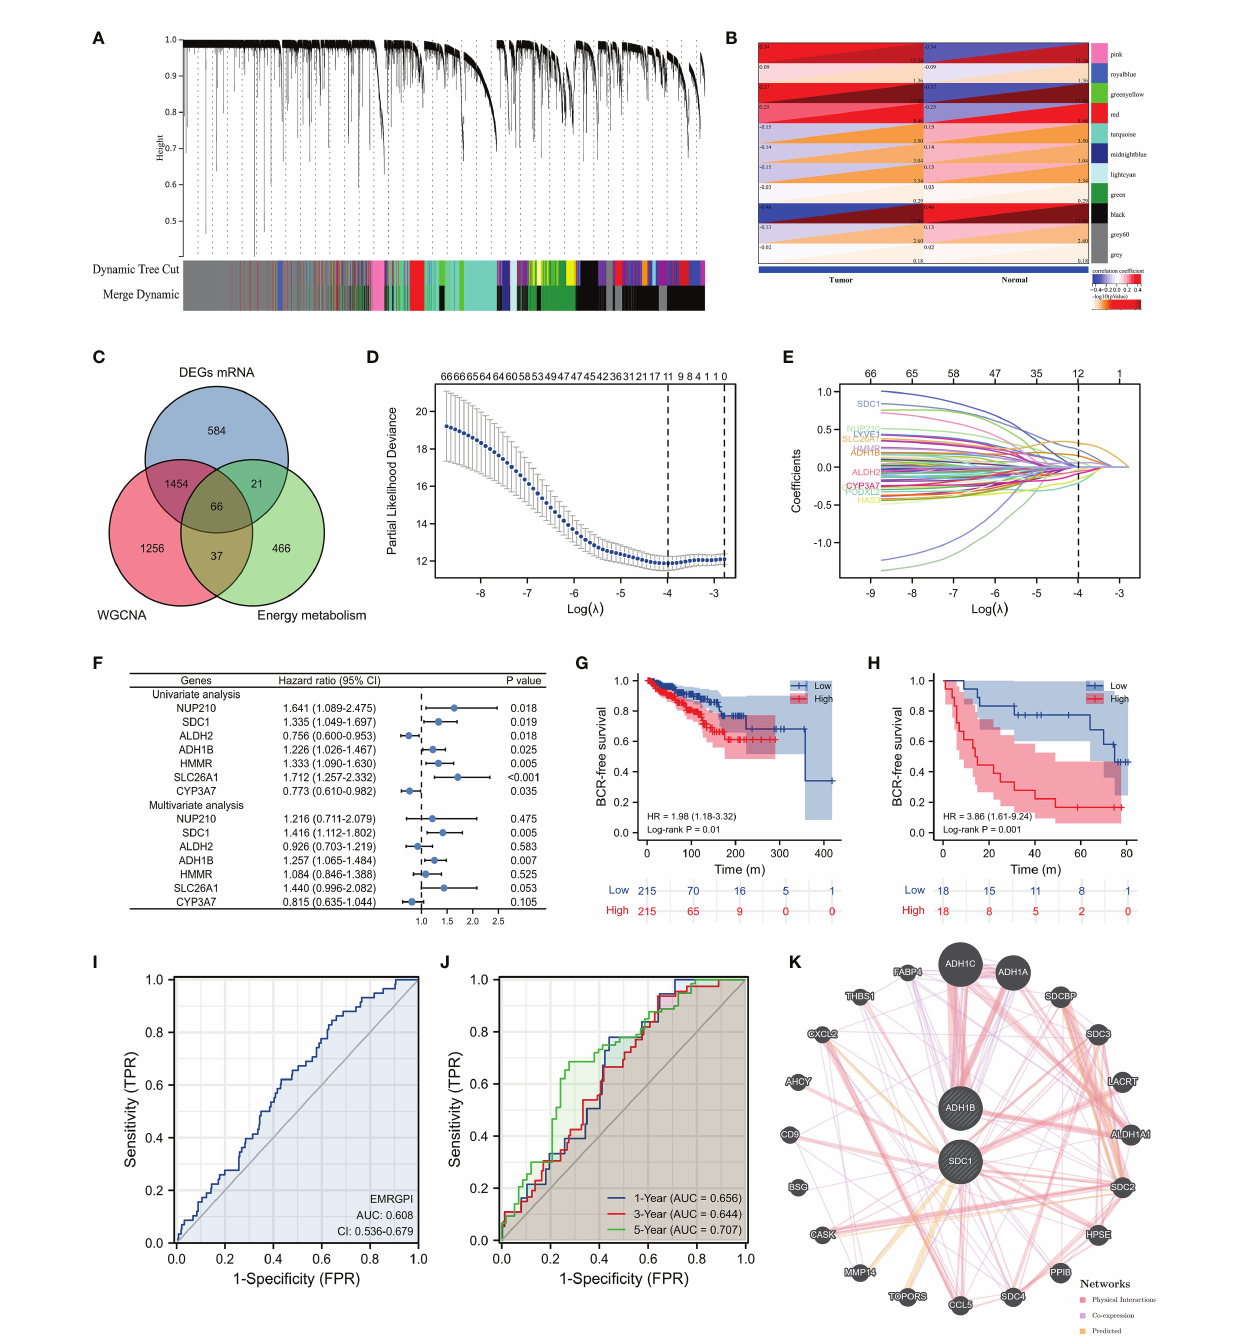
FIGURE 1 | Identi fi cation of EMRGPI and its clinical values. (A) gene cluster plot showing the process of WGCNA analysis; (B) modules and phenotype showing 2183 genes in the black, greenyellow, and pink modules which were highly related to tumor; (C) Venn plot showing the intersection of tumor-related genes, DEGs and energy metabolism-related genes; (D) variables screening through the Lasso regression analysis where the lambda value was 0.0185; (E) trajectory diagram of the 11 genes identi fi ed through the Lasso regression analysis; (F) forest plot showing the COX regress analysis of genes associated with BCR-free survival; (G) Kaplan-Meier curve showing survival difference of high- and low-risk group in the TCGA database; (H) Kaplan-Meier curve showing survival difference of high- and low-risk group in the GSE46602 (17); (I) ROC curve showing the diagnostic ability of EMRGPI in distinguishing BCR from no BCR; (J) Time-dependent ROC curve showing the diagnostic ability of EMRGPI in distinguishing BCR from no BCR; (K) Gene interacted with ADH1B and SDC1. BCR, biochemical recurrence; DEGs, differentially expressed genes; EMRGPI, energy metabolism-related gene prognostic index; WGCNA, weighted gene co-expression network analysis; mRNA, message RNA; ROC, receiver operating characteristic curve. prostate cancer patients were divided into high- and low-risk groups according to the median of the EMRGPI